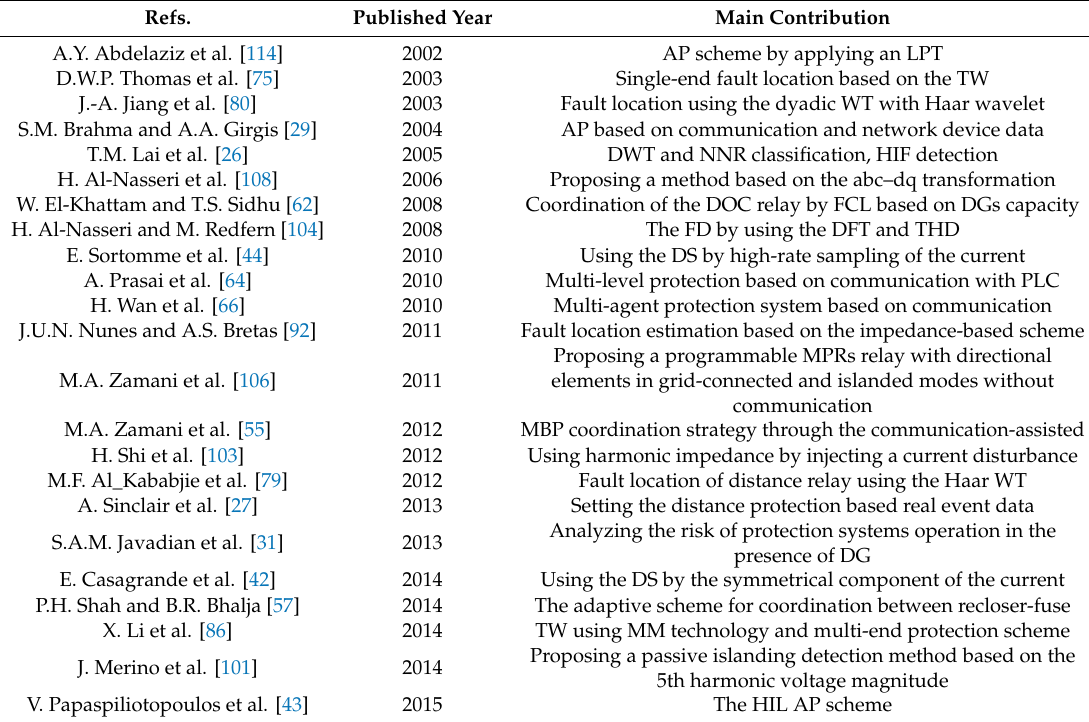
Table 2. Classification of important research works in the field of protection